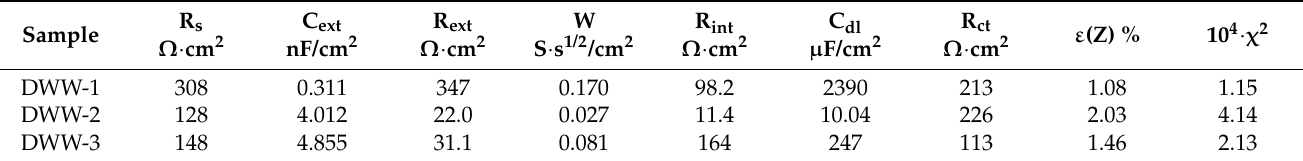
Figure 22. Equivalent circuit, surface physical model, and Boukamp representation for modelling EIS data obtained for samples immersed for 90 days in corrosion environments. Table 9. Boukamp circuit elements parameter values R(C(R(W(R(CR))))) for nodular cast iron samples immersed for 90 days in synthetic domestic